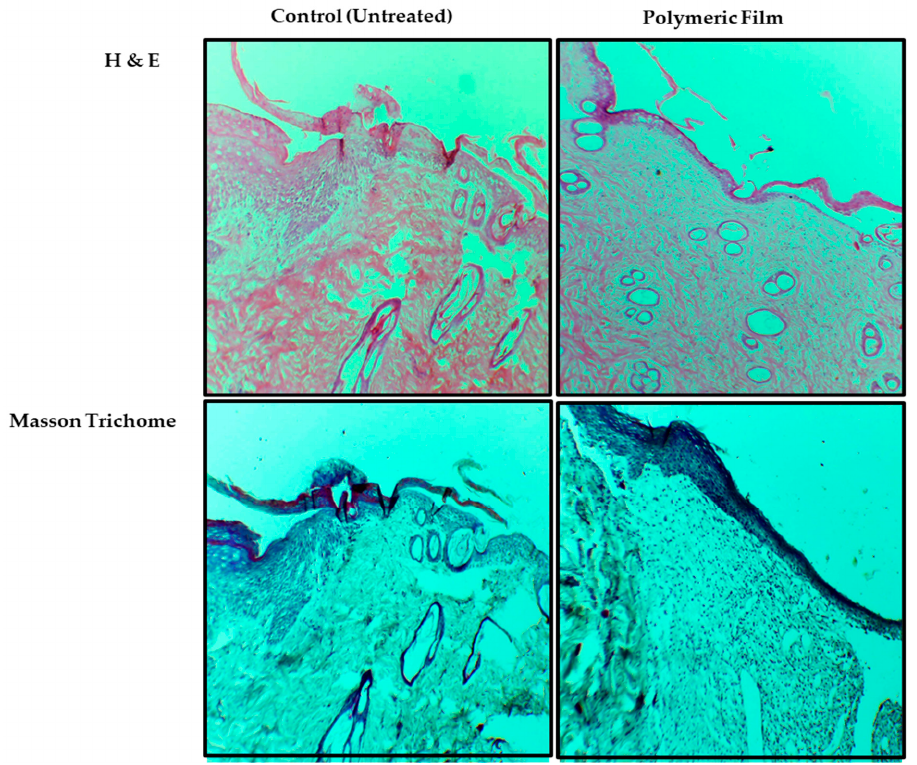
Figure 11. Photomicrographs showing the histological analysis of wound healing at day 14 after H&E and Masson trichrome staining at ×10 magnification.